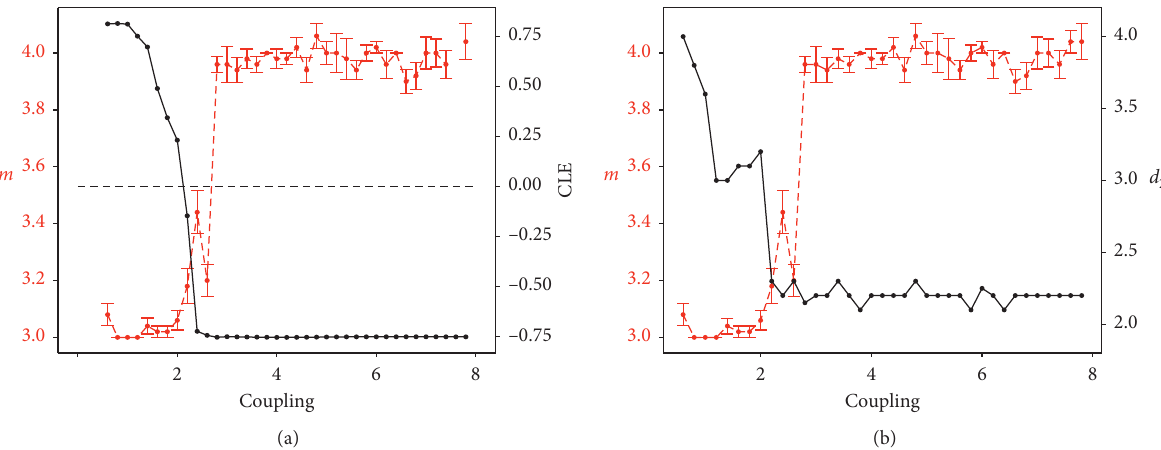
Figure 2: Lorenz driven by Rossler system. (a) Estimated m and conditional Lyapunov exponents, as a function of coupling strength. (b) Estimated m and correlation dimension d . 2